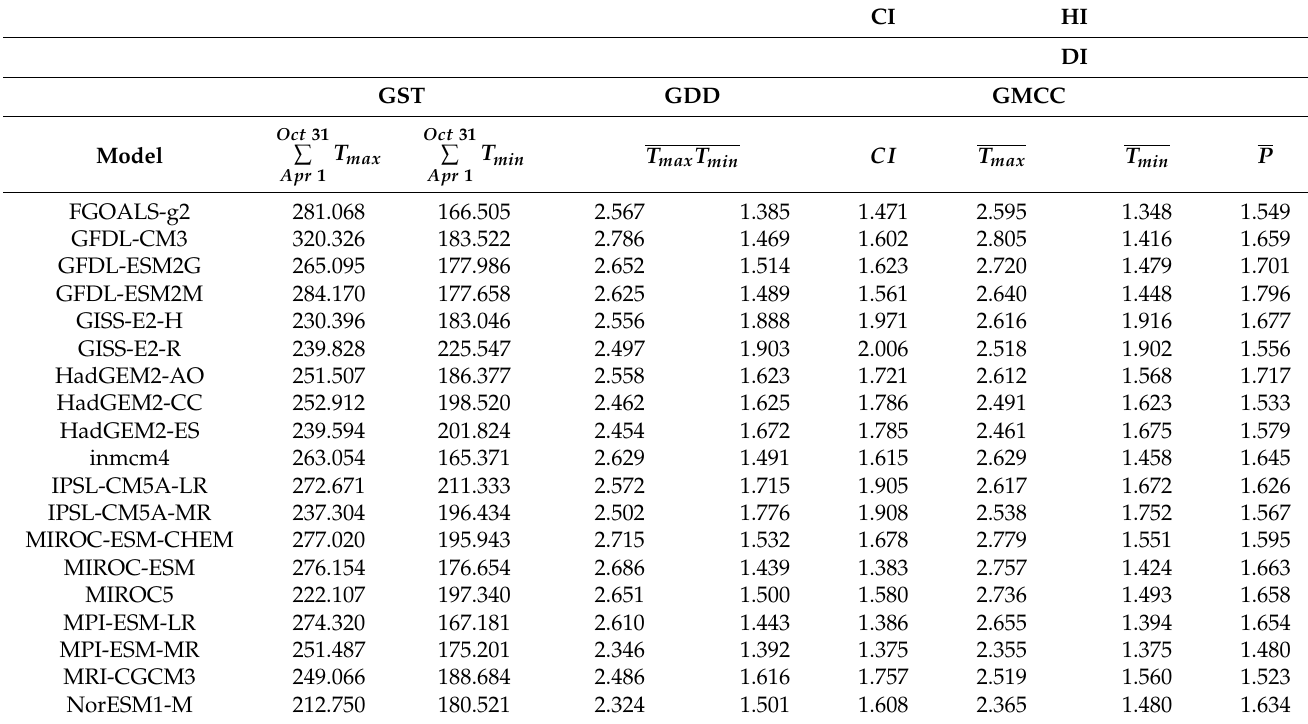
Figure 2 presents viticulture climate classification directed LOCA CMIP5 model rel- ative RMSE values, E ∗ , and median skill values, δ , also normalized such that their i ( obs ) means are one. Each row of Figure 2 has its own color scale wherein its minimum, mean, and maximum are blue, white, and red, respectively. Hence, for any given row, models color coded with shades of blue/red possess more/less skill than the ensemble mean. The first two/third and fourth/fifth and sixth/fifth through seventh/fifth through eighth rows of Figure 2 are the variables specific for the calculation of the GST/GDD/HI/DI/GMCC, respectively. The ninth through fourteenth rows of Figure 2 are the computed median skill values for calculation of the GST, GDD, HI, CI, DI, and GMCC, respectively. LOCA CMIP5 model median skill values vary by model and their individual